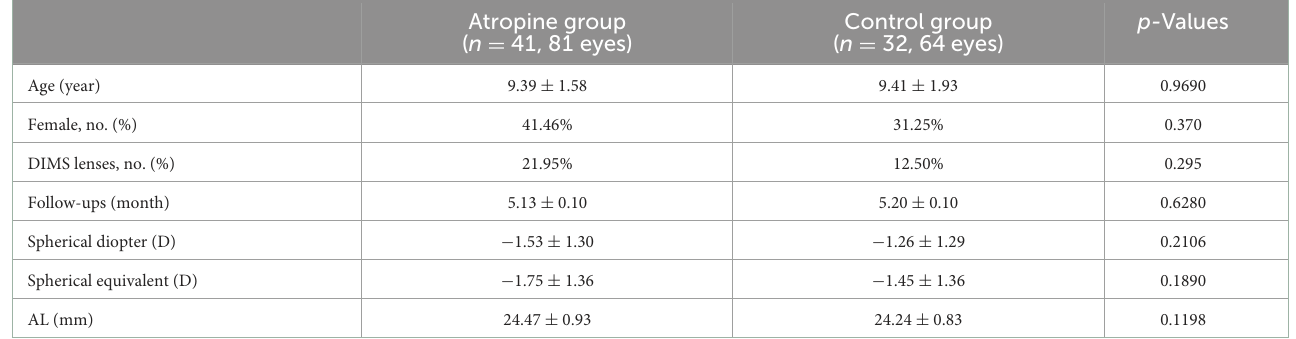
TABLE 1 Baseline general characteristics of all participants.